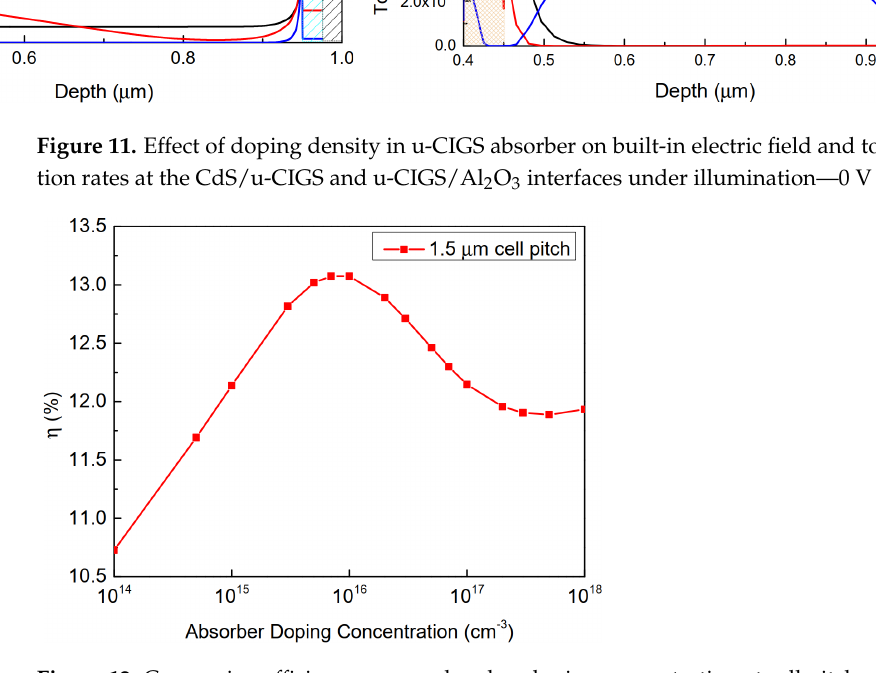
Figure 12. Conversion efficiency versus absorber doping concentration at cell pitch of 1.5 µm.